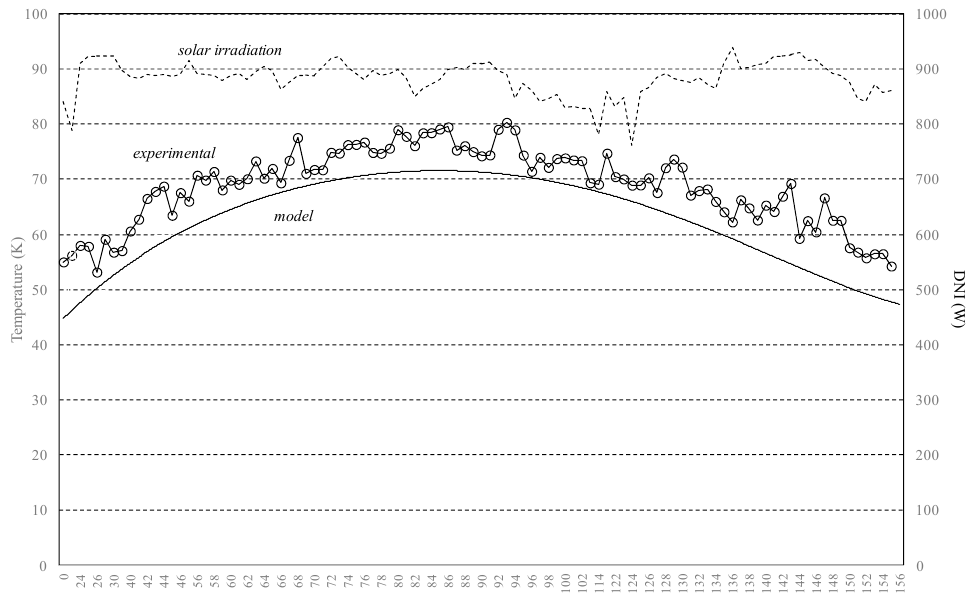
Figure 13. Theoretical and experimental comparison for a sunny day corresponding to the inferior part of the tube that faces the mirror.